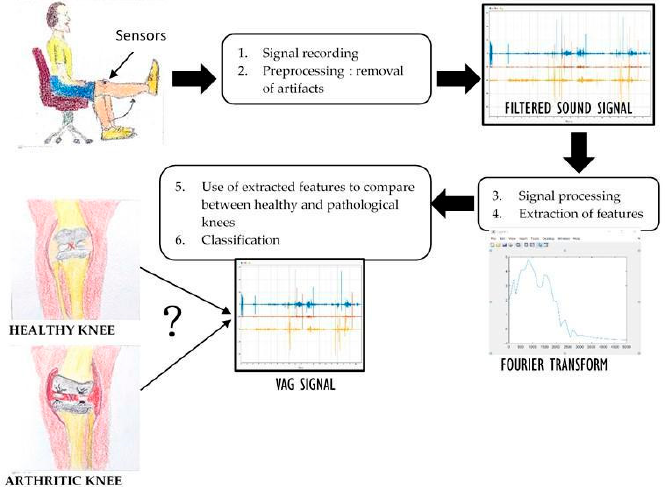
Figure 3. Diagram of a typical knee joint vibration arthrographic signal recording and analyzing process.